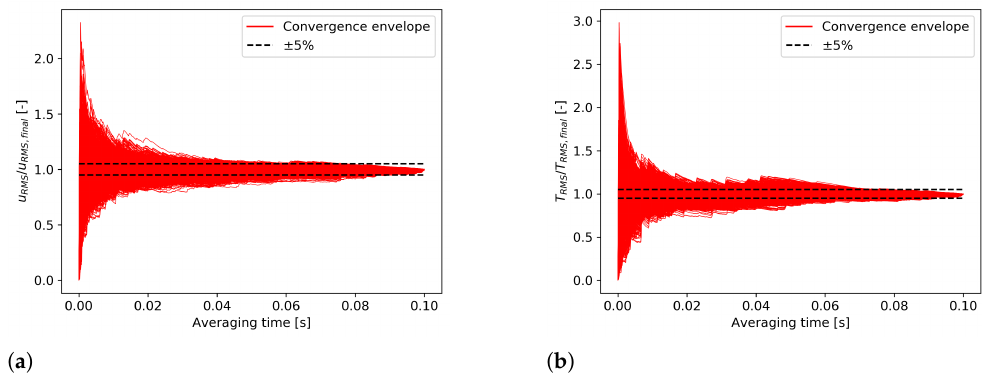
Figure 4. Convergence envelope of the local RMS values for the axial velocity and static temperature at the turbine inlet as a function of the averaging time. The dashed lines define the ( a ) Axial velocity. ( b ) Static